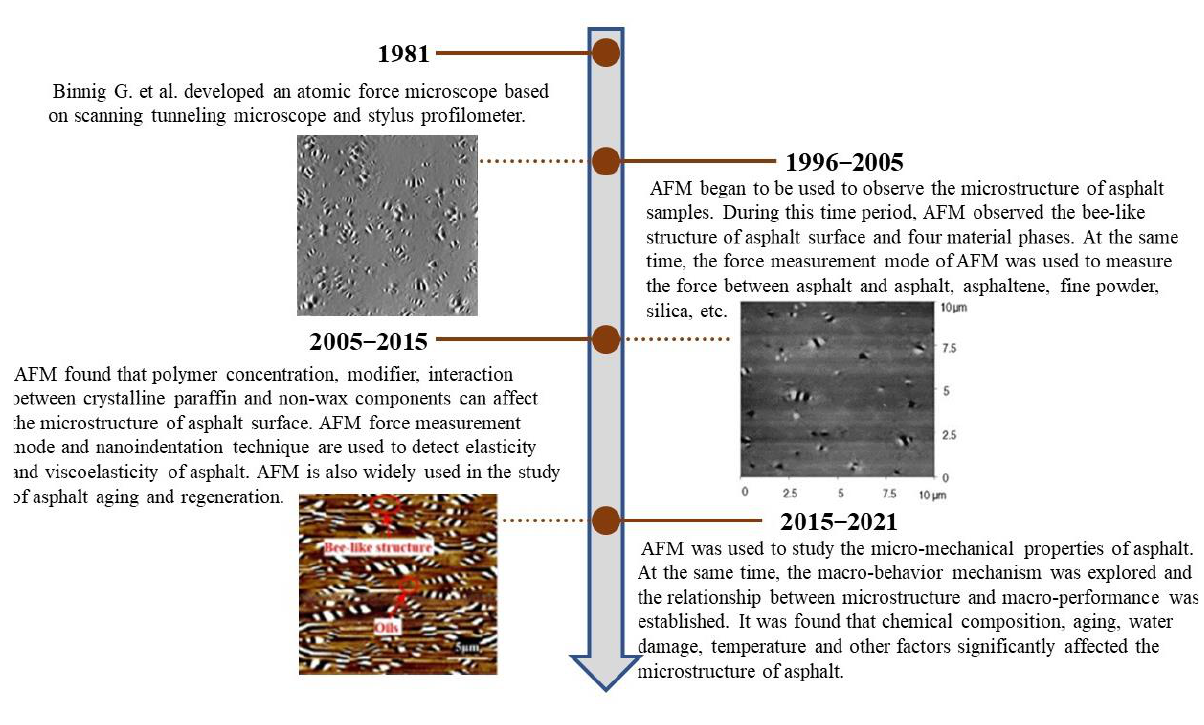
Figure 5. The history of the use of AFM to analyze asphalt [50,72,76]. © The Authors. Published by Elsevier. Table 2. The difference between the two AFM sample preparation methods